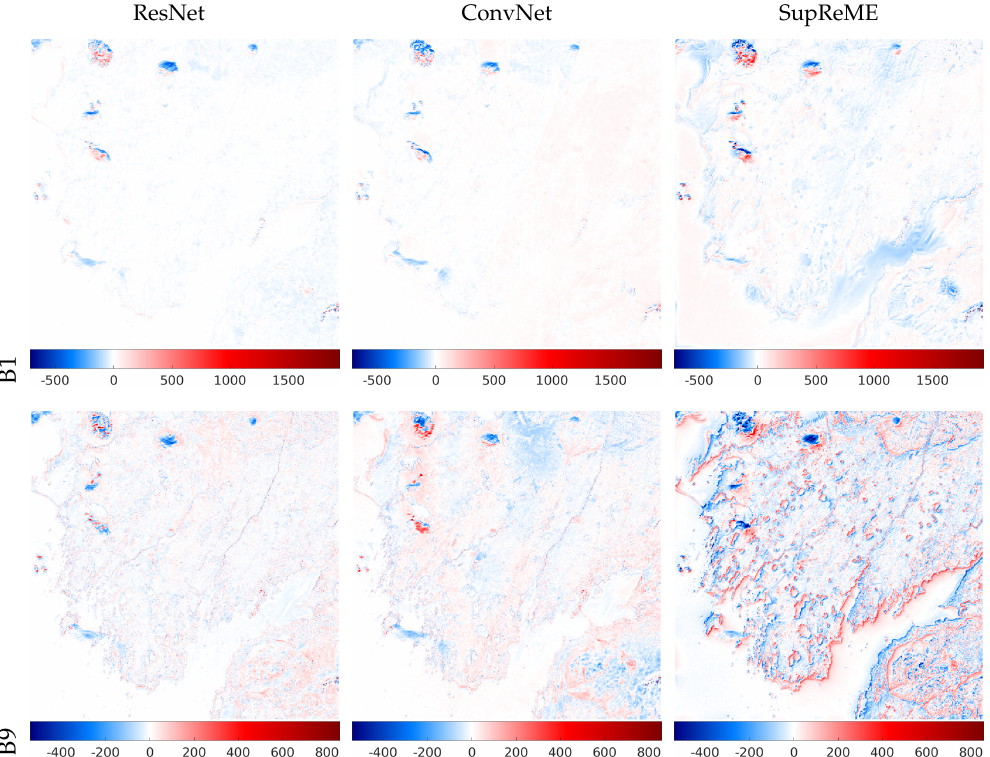
Figure 15. Residual plots for bands B1 and B9 obtained for all methods at 60 m resolution. Residuals for B1 are shown in the top row while residuals for B9 are shown in the bottom row.